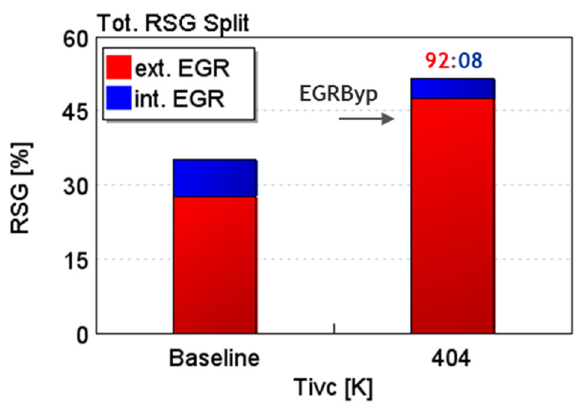
Figure 20. Total residual split between ext.EGR and int.EGR and Tivc, corresponding to the EGRByp strategy at B10.